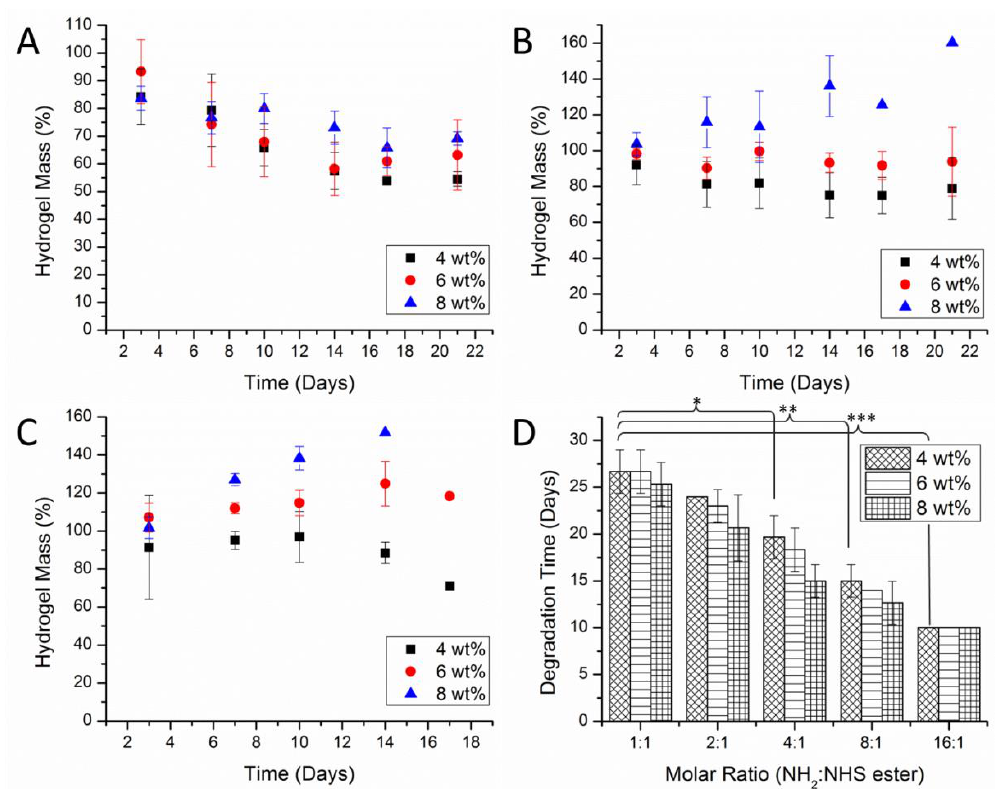
Figure 8. The effect of hydrolytic degradation on the hydrogel mass for ( A ) 1:1, ( B ) 2:1 and ( C ) 4:1 molar ratio P(KA)/4-PEG hydrogels, and ( D ) the effect of molar ratio on the final degradation time of the P(KA)/4-PEG hydrogels is shown. The effect of molar ratio was found to be statistically significant as determined from Student’s t -tests. This is indicated by the single asterisk (*) for p < 0.05, the double asterisks (**) for p < 0.01 and the triple asterisks (***) for p < 0.001 for the 4 wt% hydrogels. The effect of concentration on the final degradation time was not statistically significant.